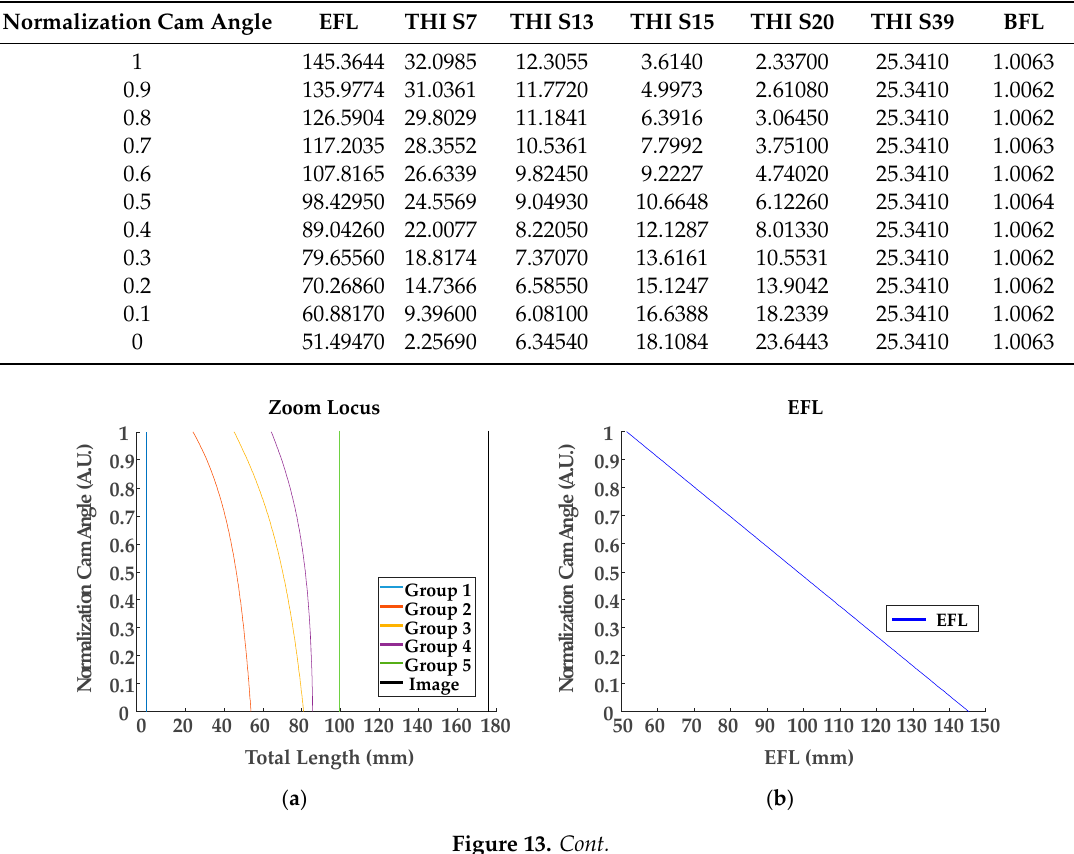
Table 13. After moving the third and fourth lens groups to correct EFL and BFL, results of reapplying the Padé approximation to linearize EFL for the optical system shown in Figure 10.